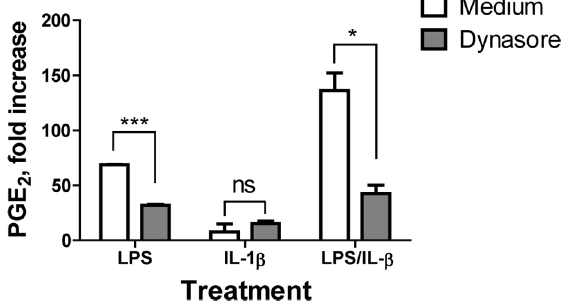
Figure 9. Endocytosis of TLR4 is required for enhancement of PGE 2 production by IL-1 b in LPS-primed monocytes. Monocytes were left untreated or were incubated with LPS alone (10 ng/ml), or with human rIL-1 b alone (100 ng/ml) or were primed with LPS for 1 h followed by 18 h incubation with rIL-1 b in presence of GTPase inhibitor dynasore (10 m M, grey bars) or medium alone (open bars). At the end of incubation period, cell culture supernatants were assayed for PGE 2 production. Data are shown as fold increase in PGE 2 over untreated monocytes. Data represent average 6 STDEV for monocytes obtained from three donors. Asterisks denote significant differences between cells incubated in the absence or in presence of dynasore, ***p # 0.001; *p , 0.05; ns, not significant (p . 0.05).